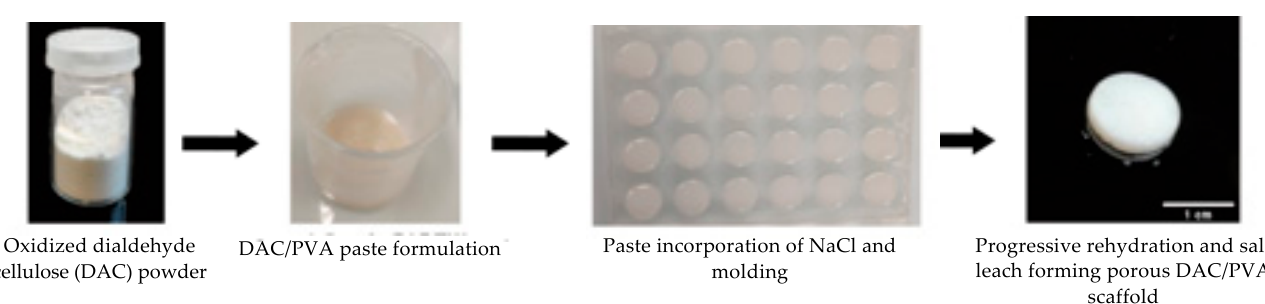
Figure 3. Photographs of the moulding process and formulation of scaffolds based on partial dialdehyde cellulose (here, DAC 9%/PVA (2:1) 0-500 µm NaCl).